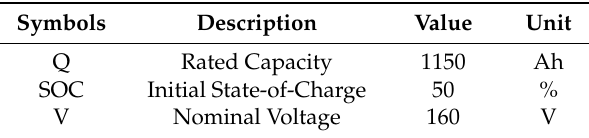
Table 2. Battery parameters used in simulation.